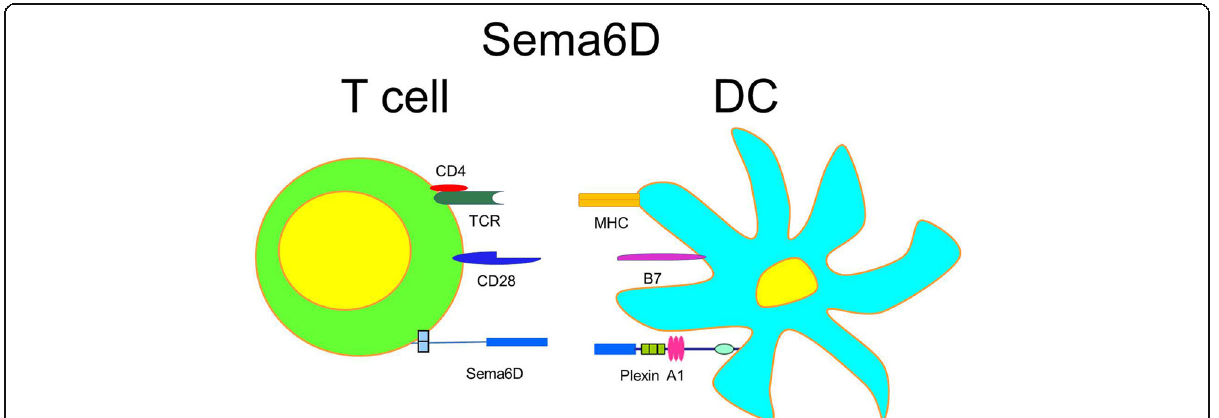
Fig. 5 Sema6D acts as indirect T cell costimulatory molecule. T cell expressed Sema6D activates DC through Plexin A1 receptor. Polyclonally- or Ag-stimulated T cells upregulate Sema6D expression. Sema6D stimulates T cell viability, proliferation and cytokine production on late stages of immune